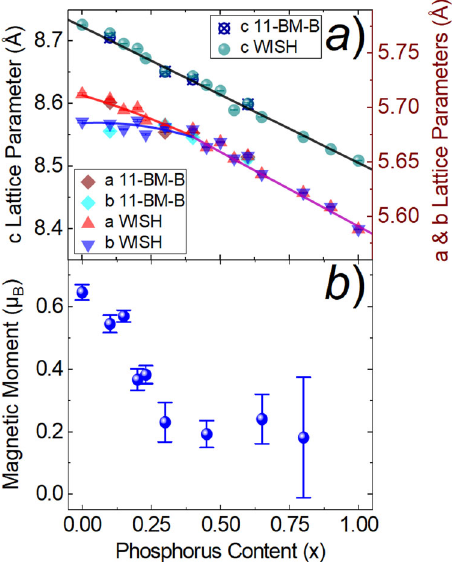
Fig. 3 Re fi ned structural parameters and magnetic moments. a Each symbol represents the re fi ned lattice parameter results as de fi ned in the legend for LaFeAs 1-x P x O at T = 10 K. End points are in close agreement with lattice parameters reported in 42 and 43 . Solid lines are fi ts of the lattice parameters as follows: black line is a linear fi t of the c-axis demonstrating adherence to Vegard ’ s Law and a successful continuous substitution of phosphorus for arsenic. Red, blue, and purple lines serve as guides to the eye. b Magnetic moment re fi ned from neutron diffraction as a function of substitution across the phase diagram. The re fi ned error bars on the sample at x = 0.8 are large due to the small magnetic phase fraction in this particular sample. Note that a fi nite moment persists even when the lattice parameters a and b are equal, signaling the onset of four-fold rotationally symmetric magnetic order. Error bars are smaller than the symbol size for the lattice parameters. For the magnetic moments, error bars are those calculated by the Rietveld re fi nement programs.